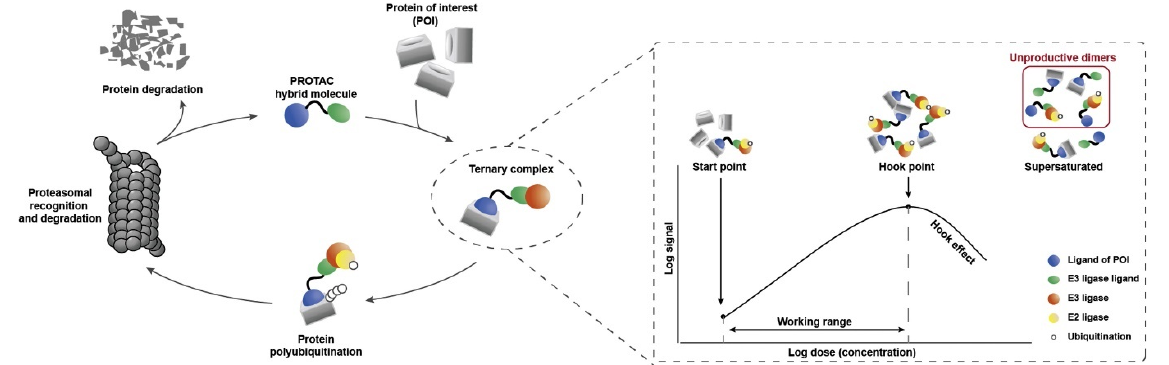
Figure 5. The generalized degradation of protein of interest (in this case, it would be ER- α ) using proteasomal ubiquitination. Cooperatively plays an essential role in forming a ternary complex, which suffers from an indigenous issue that leads to the formation of a binary complex rather than the intended ternary complex (called the “Hooks effect”). It was reproduced with permission from